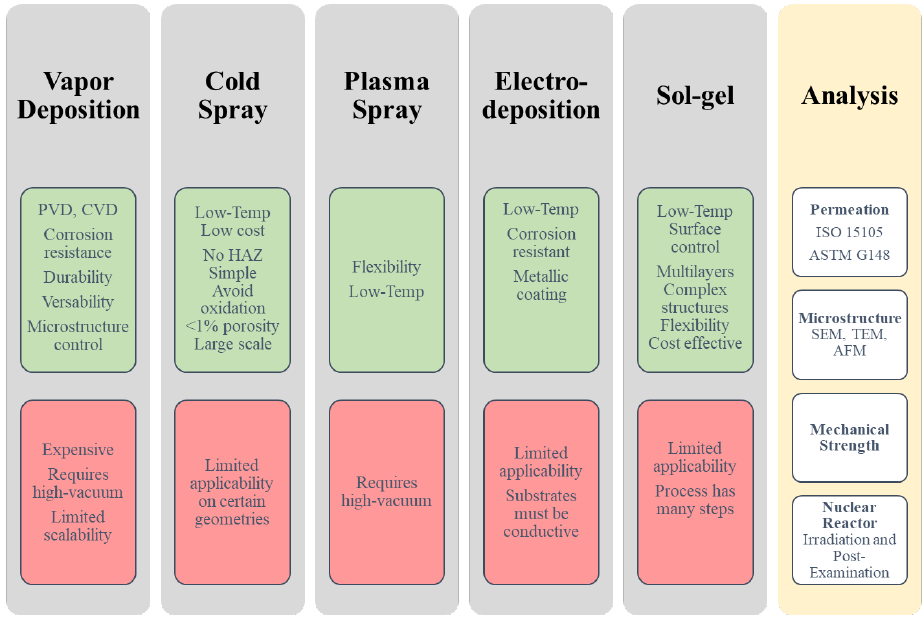
Figure 2. Comparison of five selected Coating Application techniques, pros (green) and cons (red). The right column has basic characterization techniques to analyze hydrogen permeation fabrication applicability, materials integrity, etc.